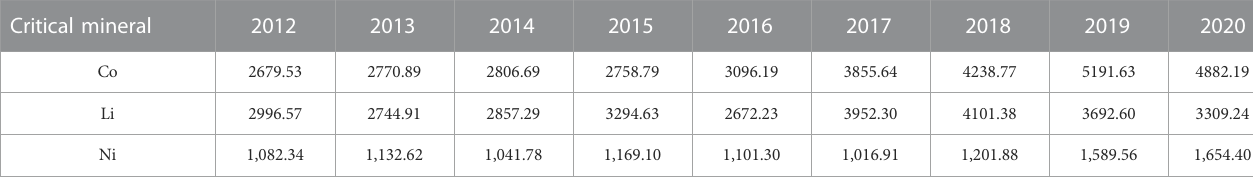
TABLE 5 Concentration index (HHI) for critical minerals. Critical mineral